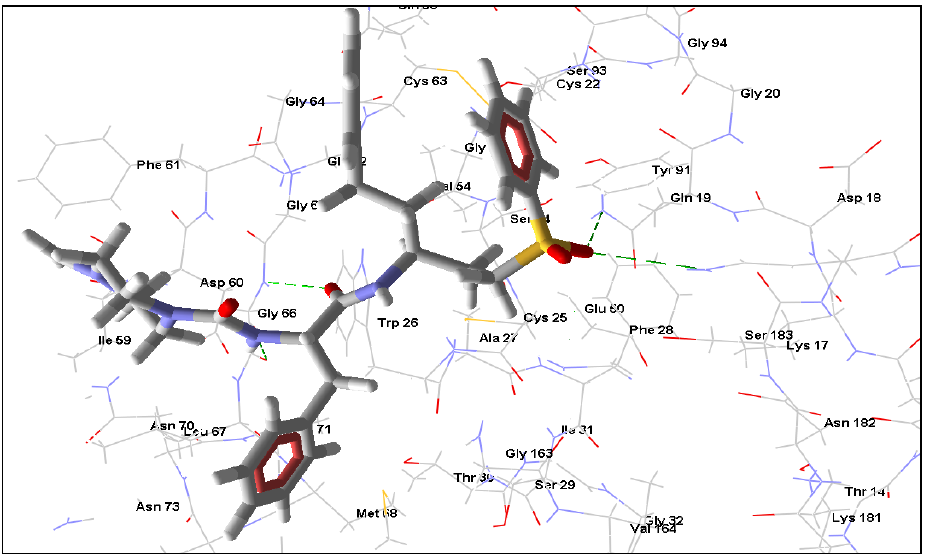
Figure 5. K777, rhodesain’s co-crystallized ligand, is shown interacting with the active site residues. Hydrogen bonding interactions are shown as green dashed